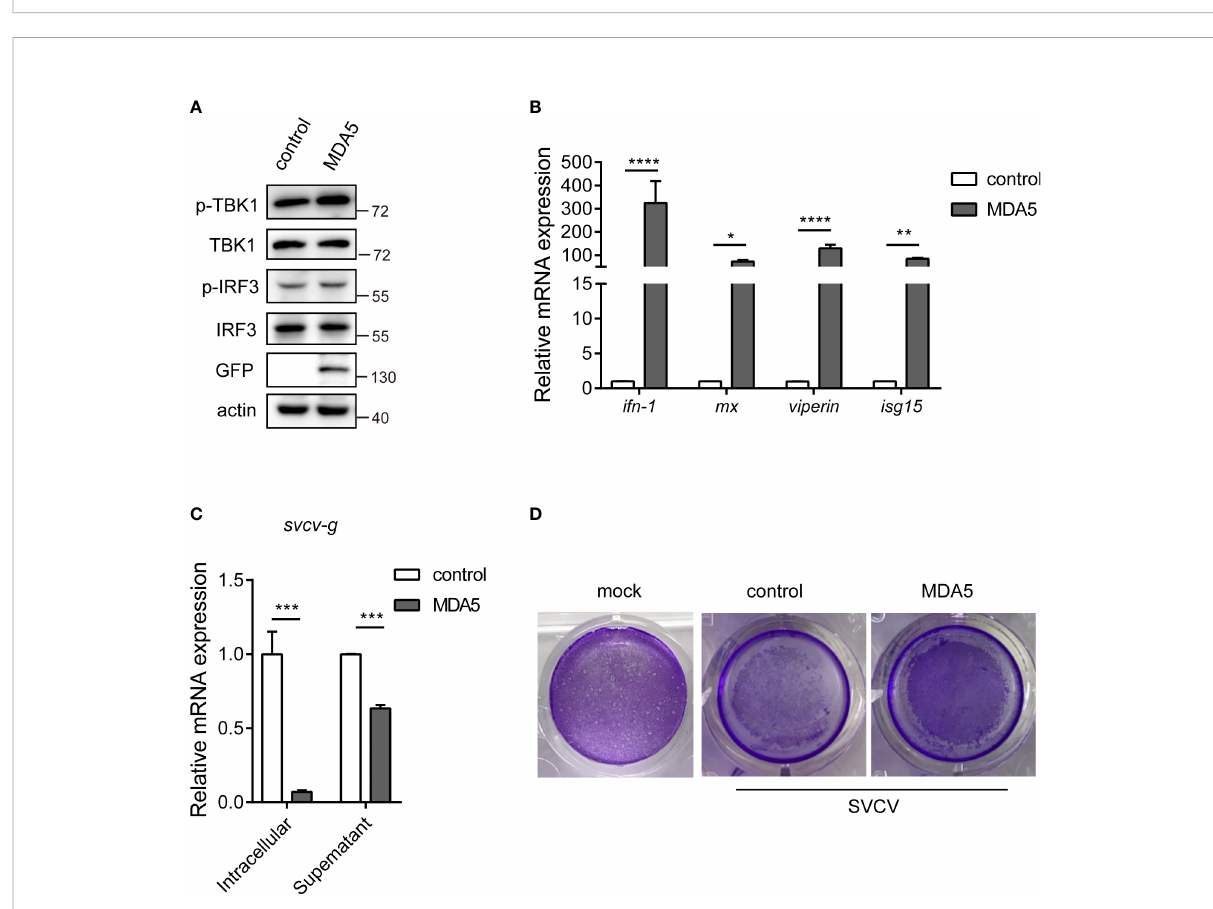
FIGURE 4 The effect of Cc MDA5 in the antiviral immune responses. (A, B) Empty vector or GFP-tagged Cc MDA5 plasmid was transfected into epithelioma papulosum cyprini (EPC) cells for 24 h. (A) Western blot was performed to test the phosphorylation of TBK1 and IRF3. b -Actin was used as an internal reference. (B) Total RNA was extracted to detect interferon-1 ( ifn-1 ), myxovirus resistance ( mx ), viperin , and interferon-stimulated gene 15 ( isg15 ) using qPCR. Data are represented as fold induction relative to the transcriptional level in control, which was set to 1. Mean ± SD (n = 3). (C, D) EPC cells were transfected with the above-mentioned plasmids. At 24 h post-transfection, the cells were stimulated with SVCV or Medium 199 and incubated at 25°C for 24 h. (C) Cell samples and supernatants were collected. The mRNA expression of the svcv-g gene was detected using qPCR. (D) The cell monolayers were stained with crystal violet, and CPEs were observed. The mock group represented the cells without treatment. Each experiment was conducted thrice. *P < 0.05, **P < 0.01, ***P < 0.001 and ****P <